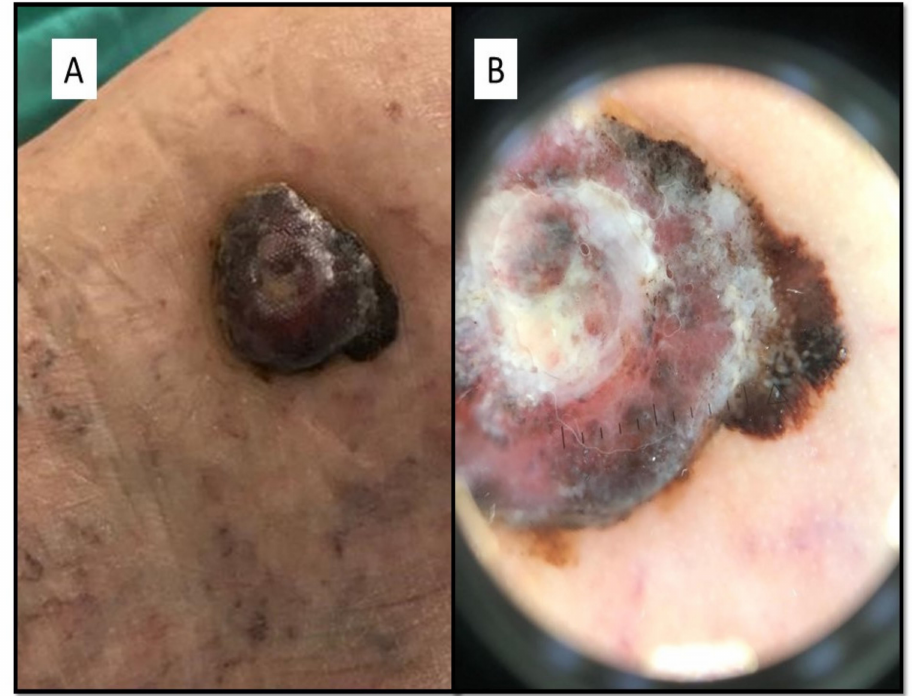
Figure 1. ( A ) Lesion consisted of a nodular part of about 3 cm in diameter and a flat, blackish, elongated part of about 1.5 cm. ( B ) Dermoscopically, the lesion was characterized by marked chromatic asymmetry, with radial striae and peripheral pigment escape, with irregular